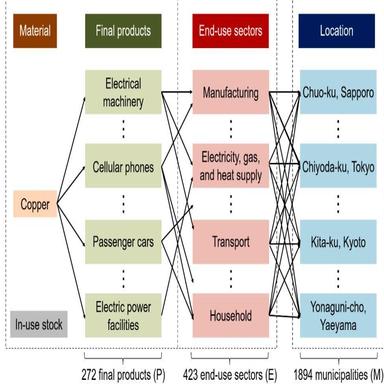
Framework for estimation of spatial distribution of in-use copper stocks in Japan.